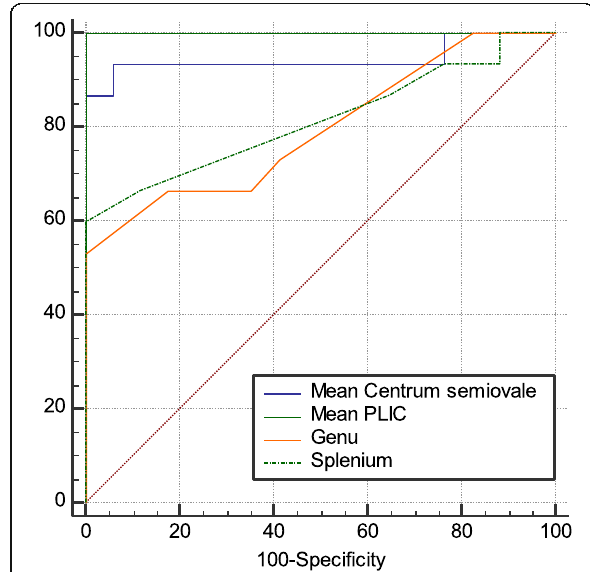
Fig. 1 ROC curve analysis for FA of PLIC (continuous green line), CSO (blue line), and genu and splenium of the corpus callosum (red and dotted green lines, respectively) where FA of PLIC ≤ 0.435 was shown to be the most statistically significant discriminator of occurrence of cerebral palsy with area under the ROC curve (AUC) = 1.000 with * p <